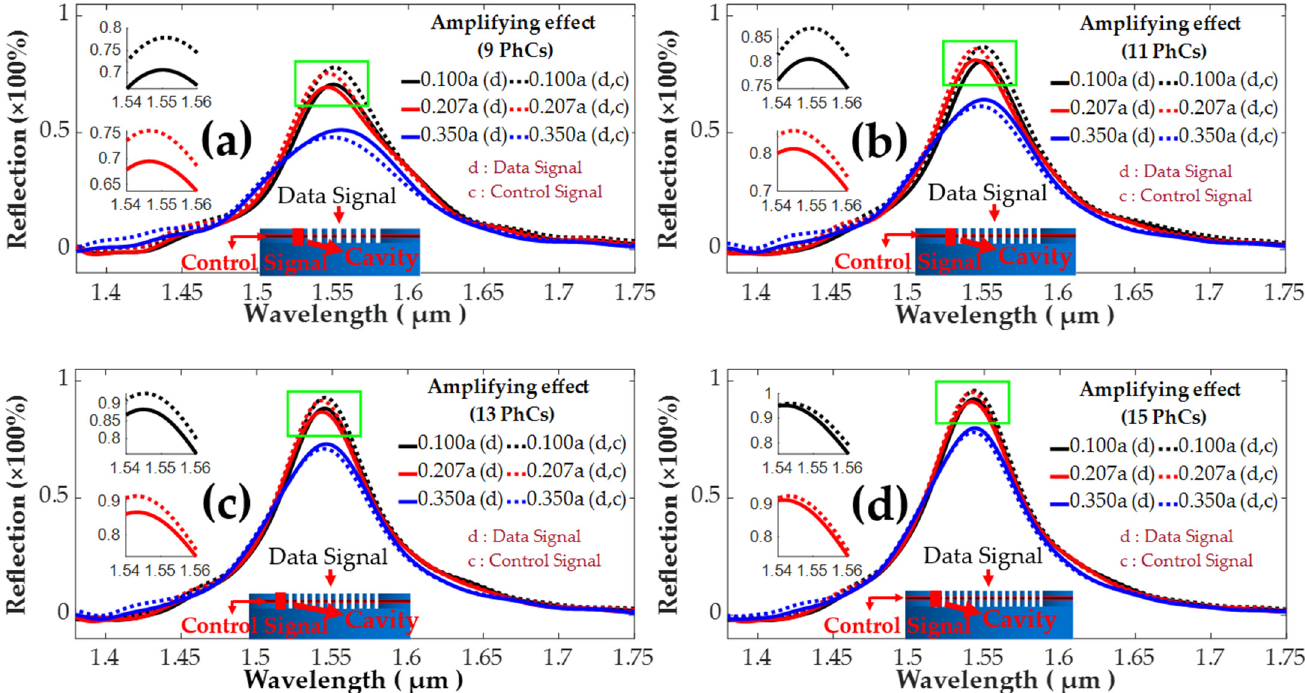
Figure 9. Reflection spectra of PhC structures for both data and control signal to investigate optical amplification and switching action. The cavity-radius is varied for a case study in different number of PhC-elements. ( a ) 9 PhC-elements ( b ) 11 PhC-elements ( c ) 13 PhC-elements ( d ) 15 PhC-elements.